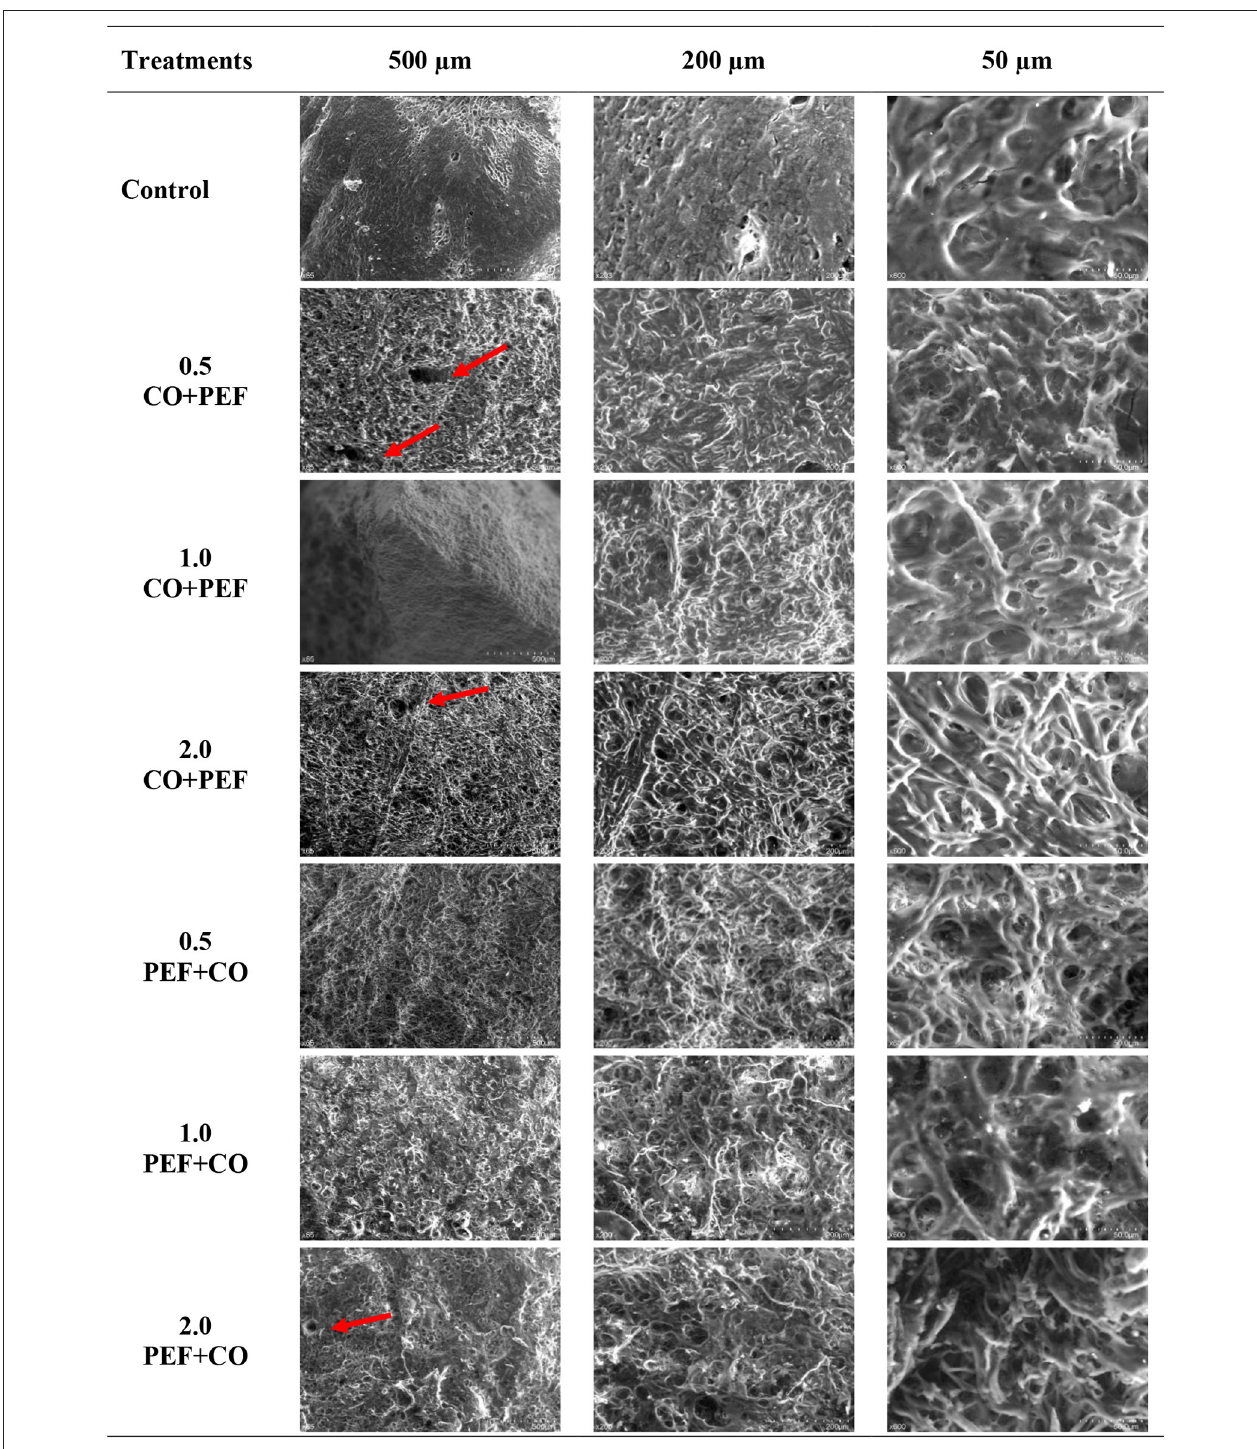
FIGURE 5 | SEM images of pretreated (PEF + CO or CO + PEF) freeze-dried Chilean abalone samples. Red arrows show PEF porosity.